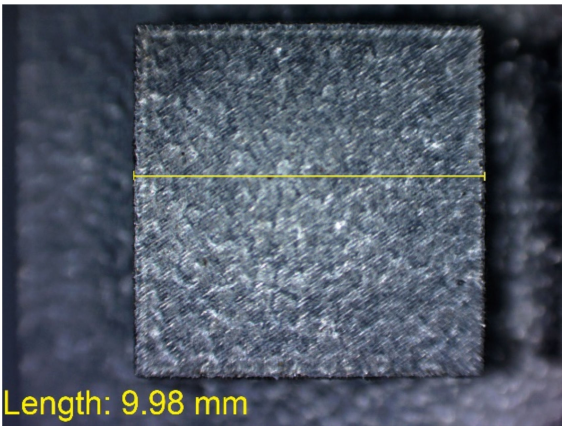
Figure 14. Measurement result for cuboidal holes and solids made in the DMLS technology: solid with a nominal width of 10 mm (L dl = 9.98 mm).